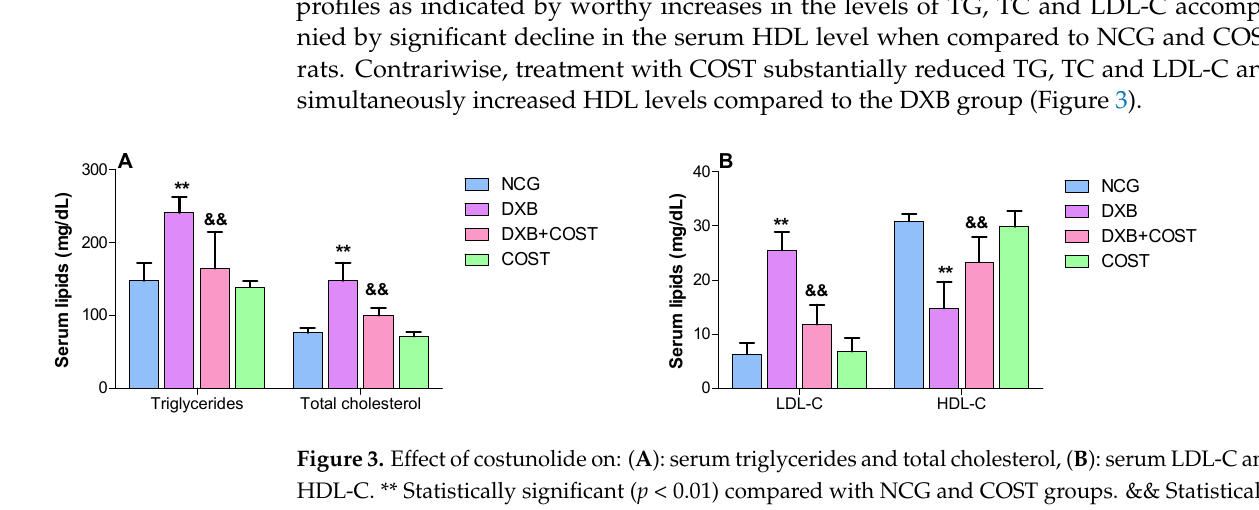
Figure 2. Effect of costunolide on: ( A ): CK-MB, ( B ): LDH, ( C ): Troponin T, ( D ): AST, ( E ): BUN, ( F ): creatinine, ( G ): uric acid. ** Statistically significant ( p < 0.01) compared with NCG and COST groups. && Statistically significant ( p < 0.01) compared with DXB group.